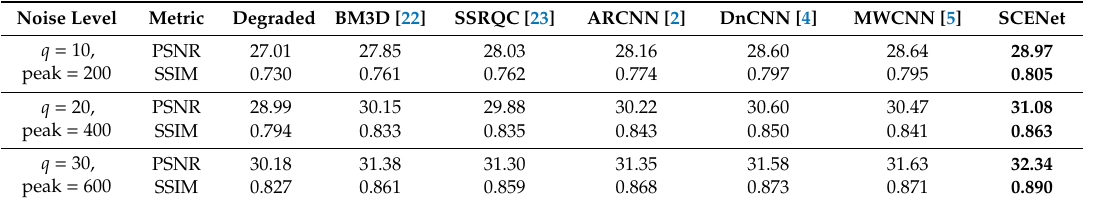
Table 2. Comparison of the objective quality on the LIVE1 database in terms of average PSNR (dB) and SSIM. Bold values indicate the best